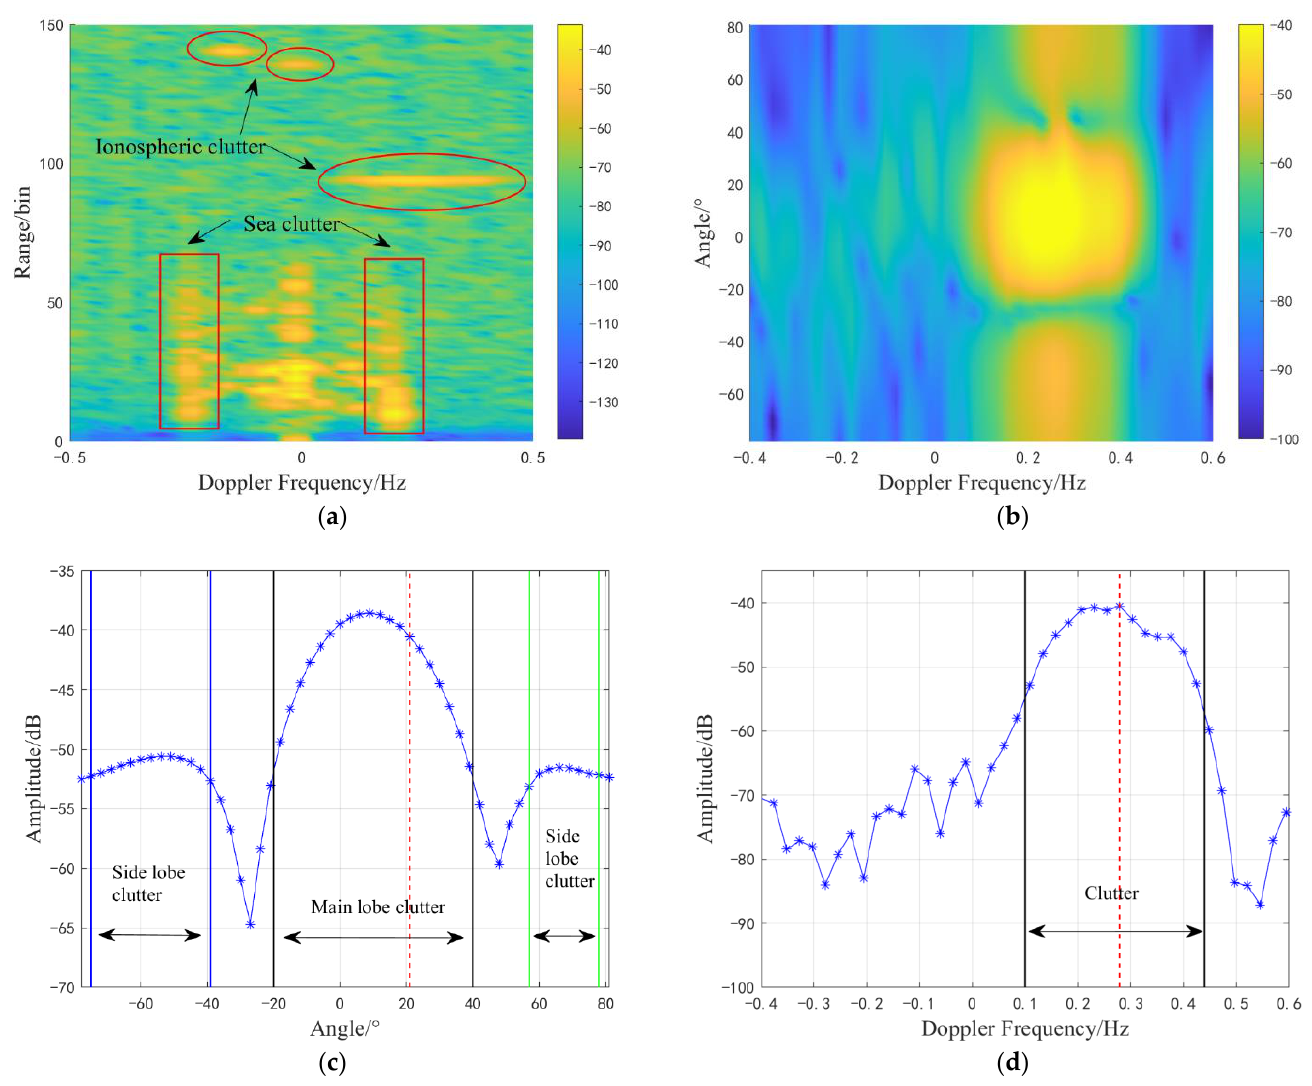
Figure 5. ( a ) Range–Doppler map of the measured data; ( b ) angle–Doppler map of the measured data; ( c ) angle curve at the Doppler frequency of the target; and ( d ) the Doppler frequency curve at the angle of the target. the angle of the